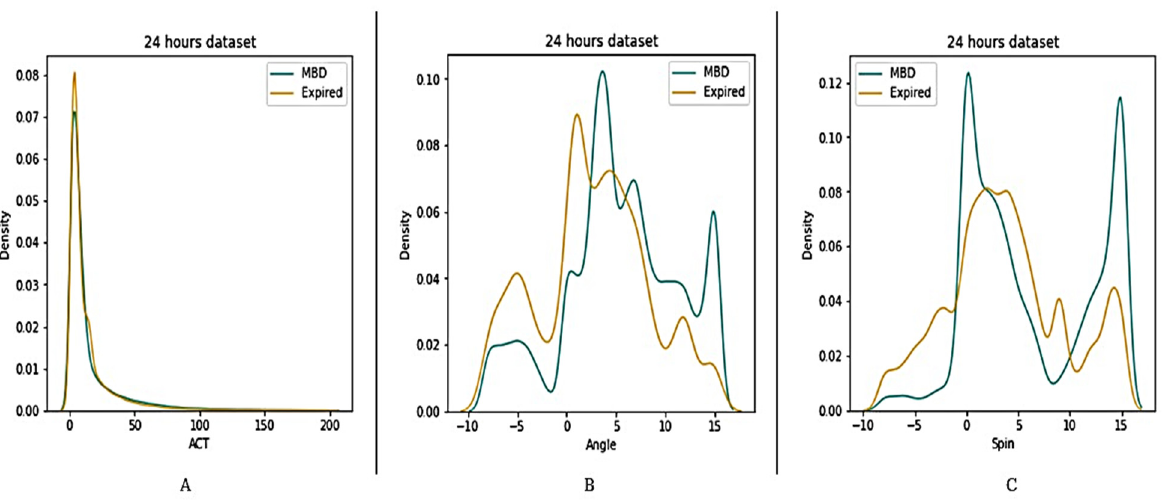
Figure 6. Description of wearable dataset at 24 h interval based on ( A ) ACT, ( B ) Angle ( C ) Spin.